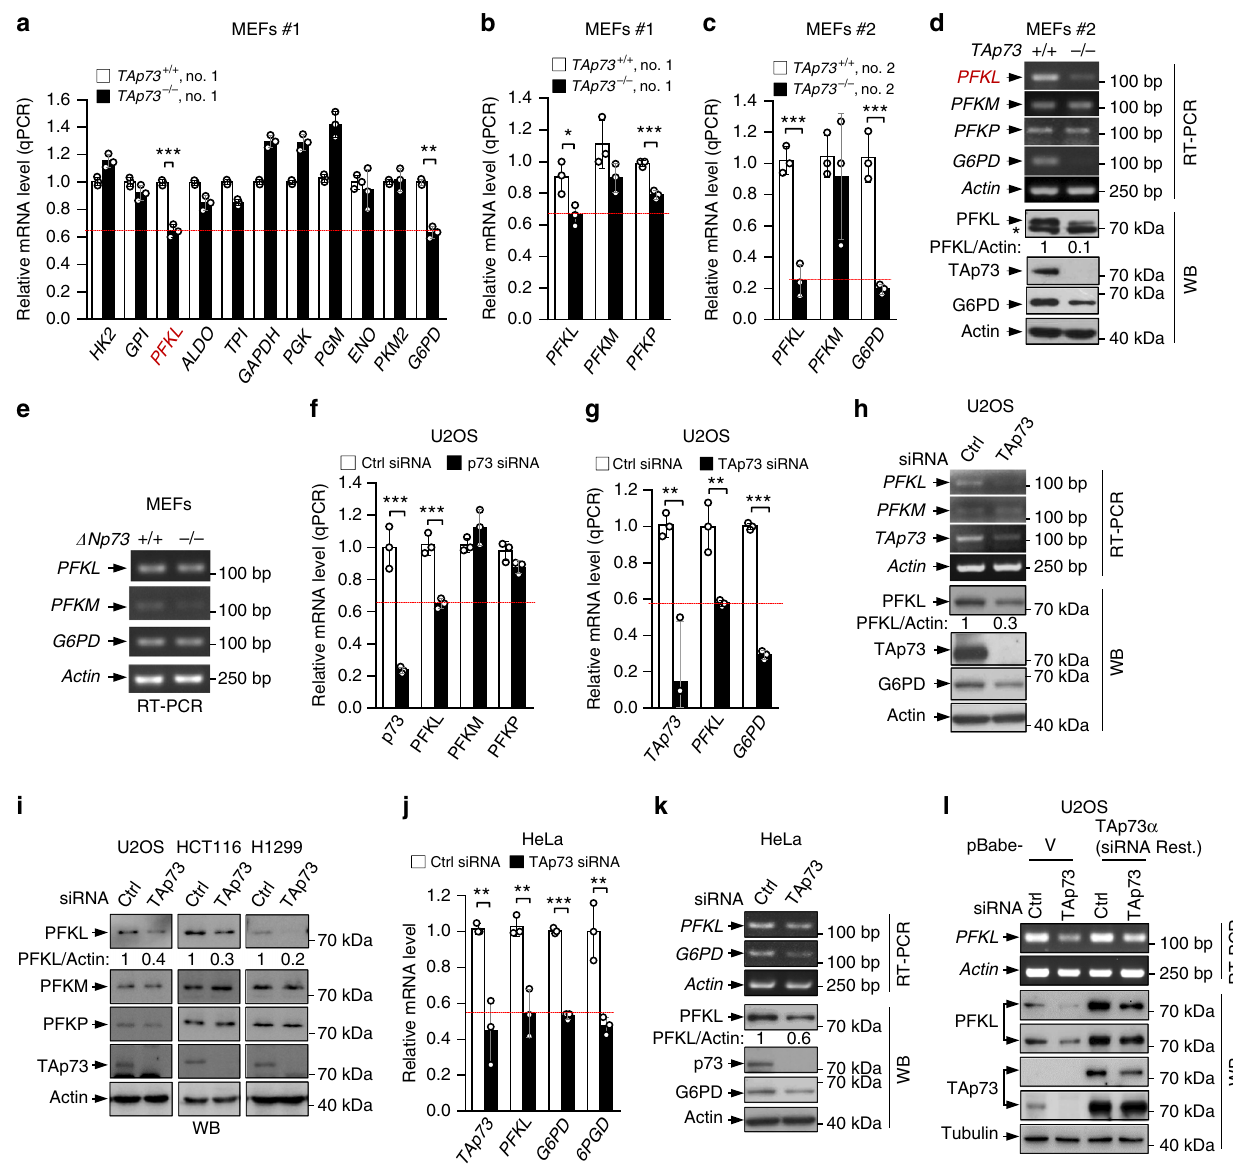
Fig. 2 TAp73 regulates the expression of PFKL. a Relative mRNA levels of glycolytic enzymes in TAp73 + / + and TAp73 − / − MEFs (clone #1), as analyzed by qRT-PCR. Data are means ± S.D. ( n = 3). b , c TAp73 + / + and TAp73 − / − MEFs (clone #1 and #2) were analyzed by qRT-PCR for expressions of PFKL, PFKM, and PFKP, and G6PD. Data are means ± S.D. (n = 3). d TAp73 + / + and TAp73 − / − MEFs (clone #2) were analyzed by semi-quantitative RT-PCR (top), and Western blot (WB, bottom). e mRNA levels of PFKL, PFKM, and G6PD in Δ Np73 + / + and Δ Np73 − / − MEF cells. Results are representative of three independent experiments. f U2OS cells were transfected with control or p73 siRNA as indicated. mRNA expression was detected by qRT-PCR (means ± S. D., n = 3). g , h U2OS cells were transfected with control or TAp73 siRNA were analyzed by qRT-PCR ( g , means ± S.D., n = 3), semi-quantitative RT-PCR ( h , top), and Western blot (WB) ( h , bottom). i U2OS, HCT116, and H1299 cells transfected with control or TAp73 siRNA were analyzed by Western blot. Results are representative of three independent experiments. j , k HeLa cells transfected with control or TAp73 siRNA were analyzed for mRNA and protein expression. Data are means ± S.D. ( n = 3). l U2OS cells stably expressing control plasmid or an siRNA-resistant TAp73 plasmid were transfected with a control or TAp73 siRNA. PFKL expression was analyzed by RT-PCR and Western